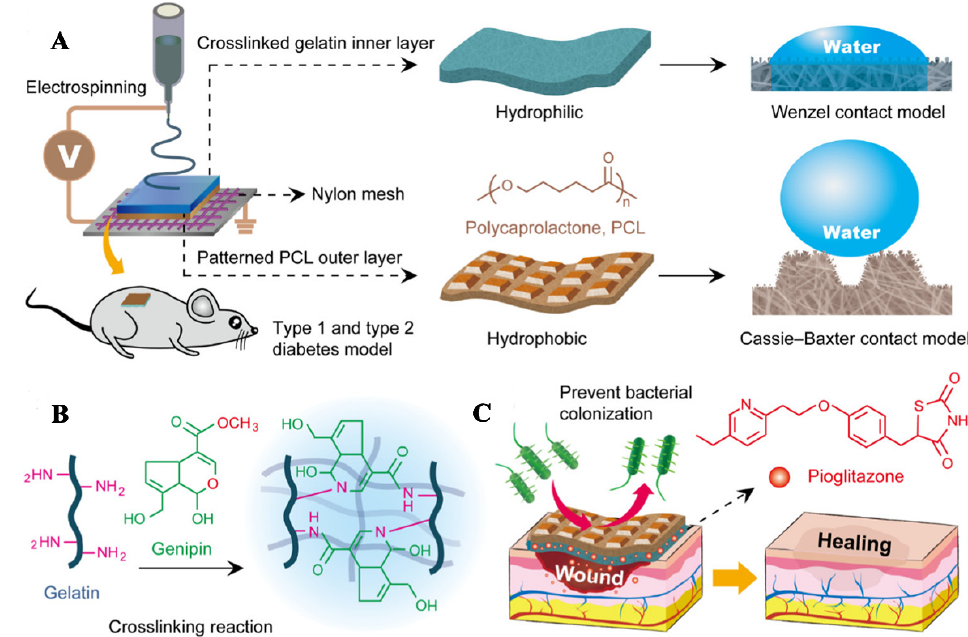
Figure 8. ( A ) Schematic diagram of the preparation of PCL/Gel-Pio nanofiber membranes, ( B ) The mechanism of the genipin cross-linking reaction of fiber membrane, and ( C ) The principle of fiber membrane promoting diabetic wound healing. Reproduced with permission from [95] , ACS, 2020.